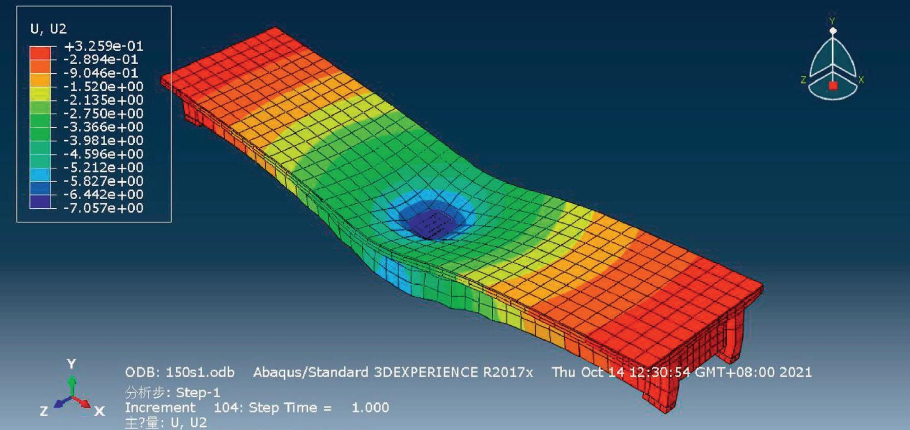
Figure 14: Fatigue load level 0.55, 1.5 million times defection graphic.